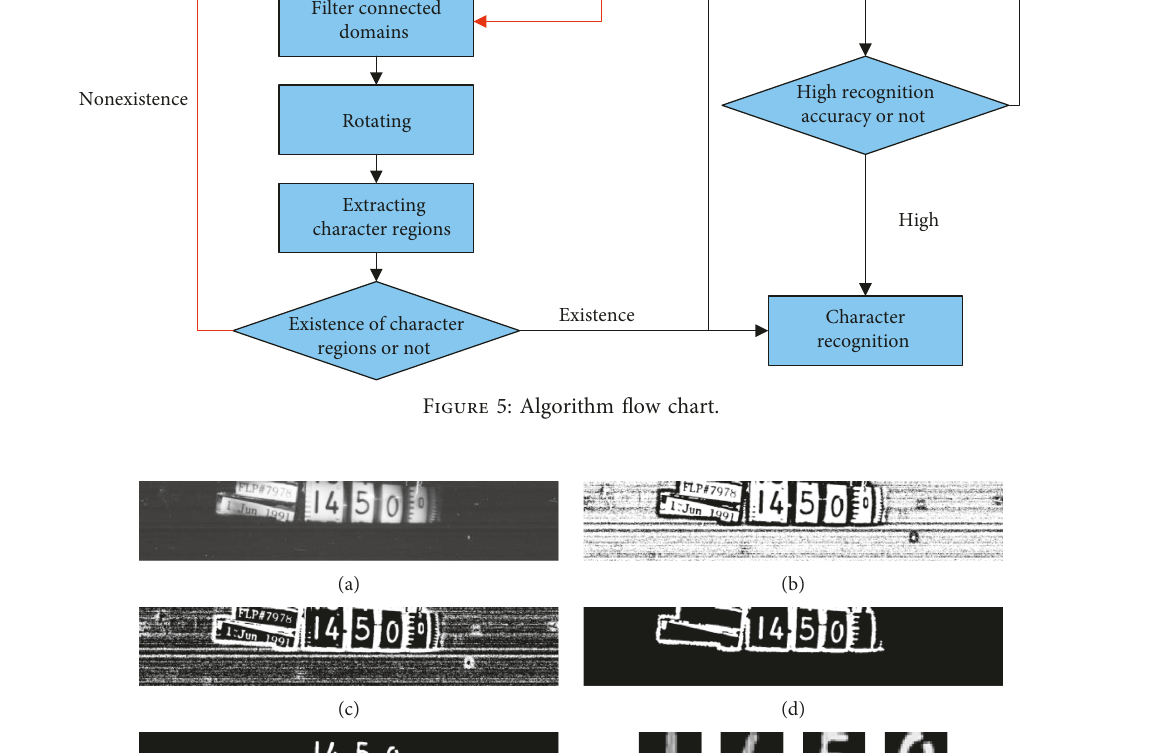
Figure 6: Extract characters from Figure 3: (a) position the time stamp and rotate, (b) after top hat operation and binarization, (c) black and white inversion of binary image, (d) extract related connectivity domain, (e) extract character regions, and (f) characters extraction result.